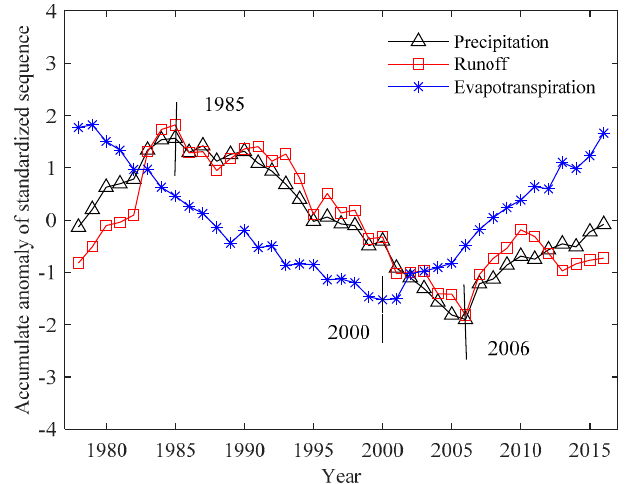
Figure 3. The variations of accumulative anomaly of runoff and precipitation.